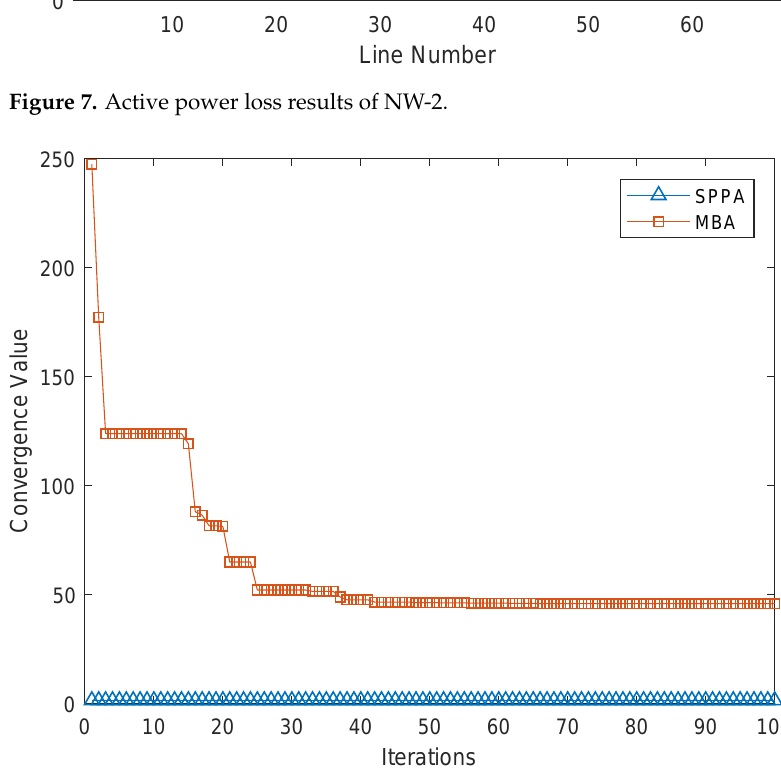
Figure 8. Algorithm convergence for